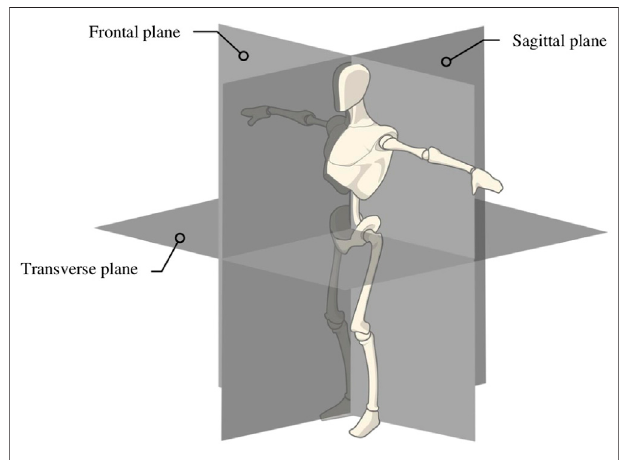
FIGURE 4 | De fi nition of the subtalar axis.